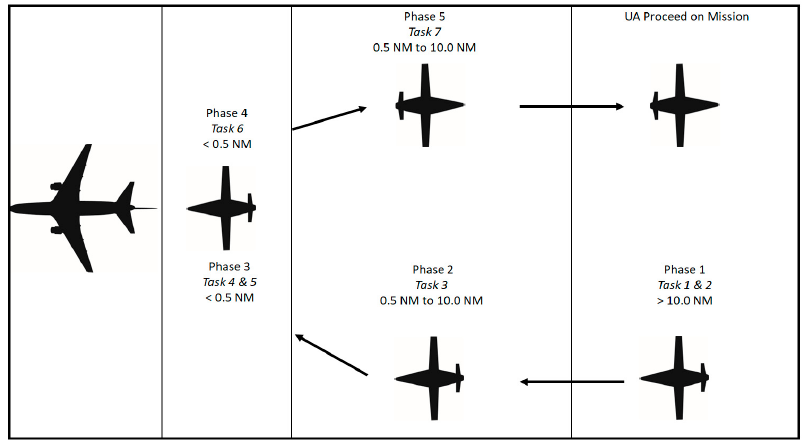
Figure 8. Visual depiction of the A3R tasks by phase.